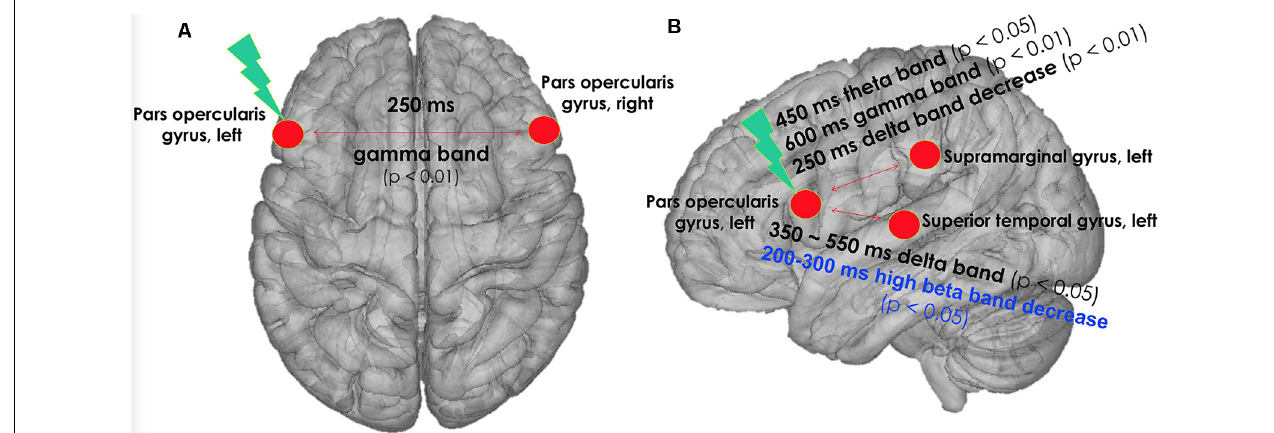
FIGURE 2 | cTBS was applied on left pars opercularis area with three pulses at 50 Hz, with an interval of 200 ms between the last pulse of a triplet and the first pulse of a triplet, for a total number of 600 pulses. The figure indicates changes in phase synchronization of TEP by real cTBS on left pars opercularis area of the language network. (A) Top view. (B) Left lateral view. Black text: real cTBS condition. Blue text: sham condition. cTBS, continuous theta-burst stimulation; TEP, TMS-evoked